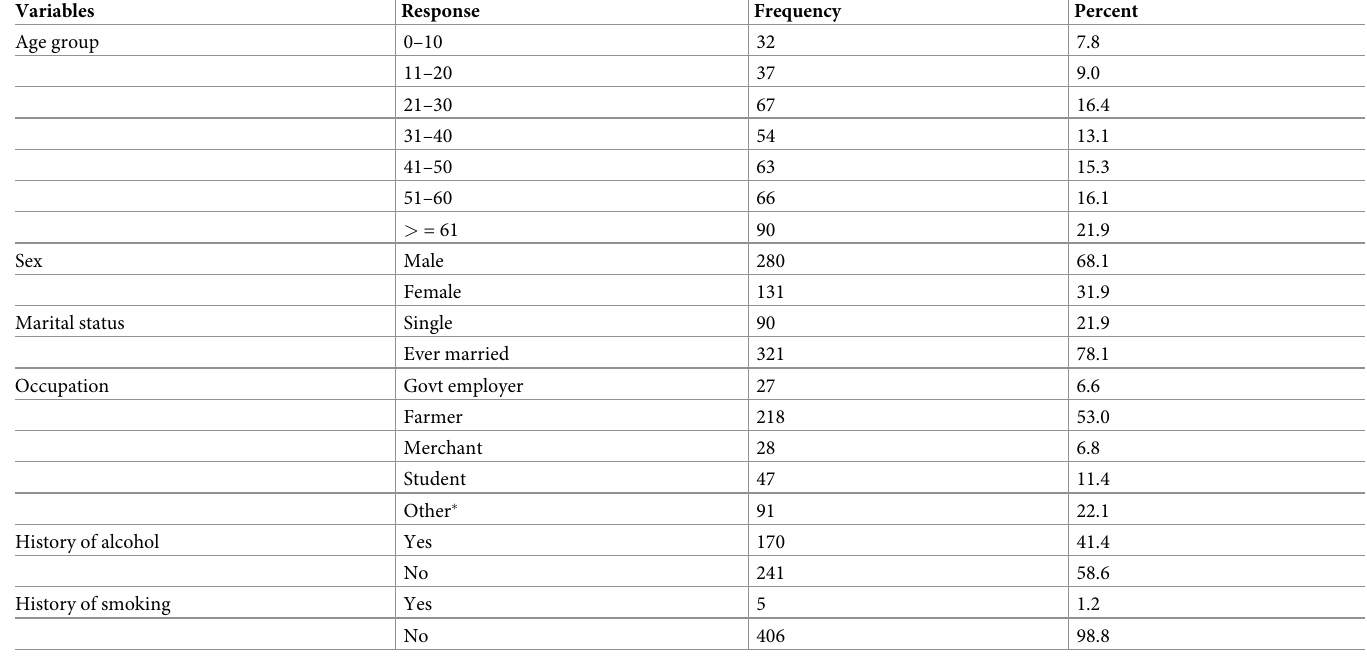
Table 1. Socio-demographic and behavioral characteristics among patients who had intestinal anastomosis surgery in Northwest Amhara regional State referral Hospitals, from February 2017 to February 2020. (n =